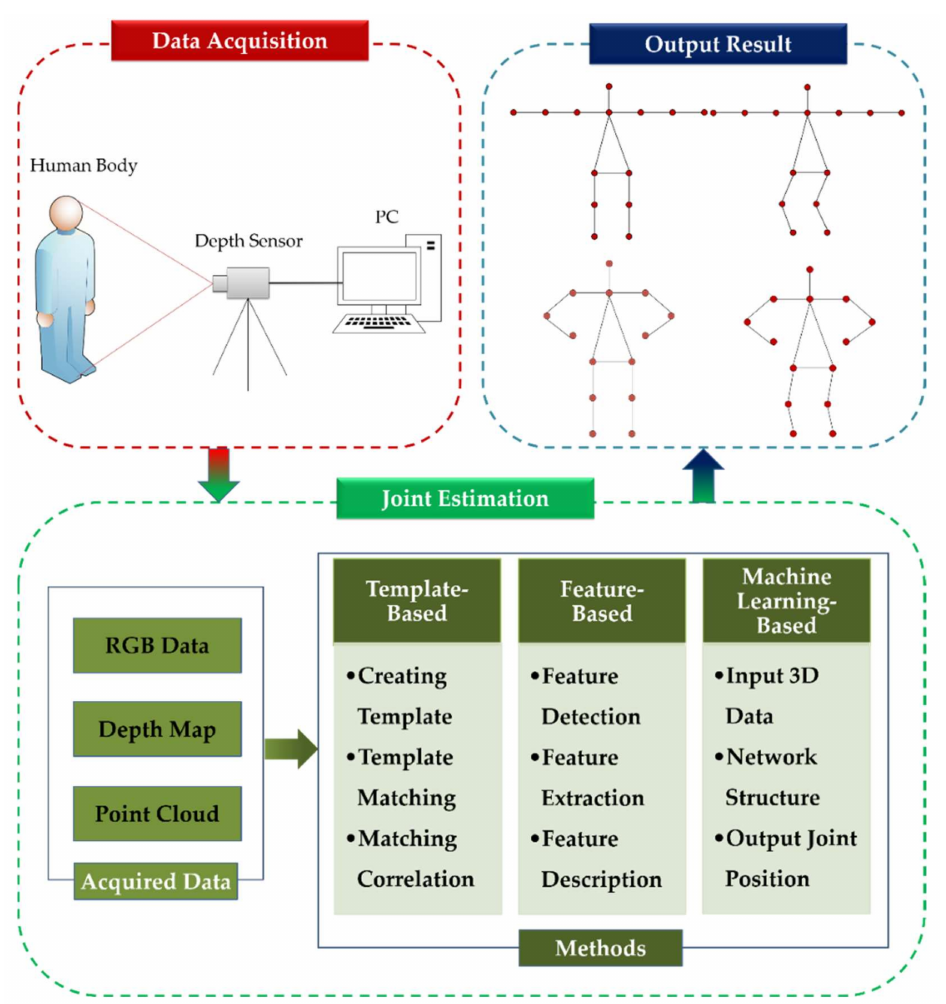
Figure 2. The flow diagram of point cloud-based 3D joints